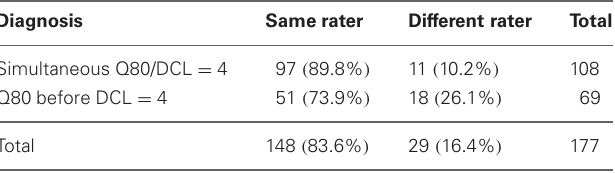
Table 2 | Diagnostic agreement between by same vs.